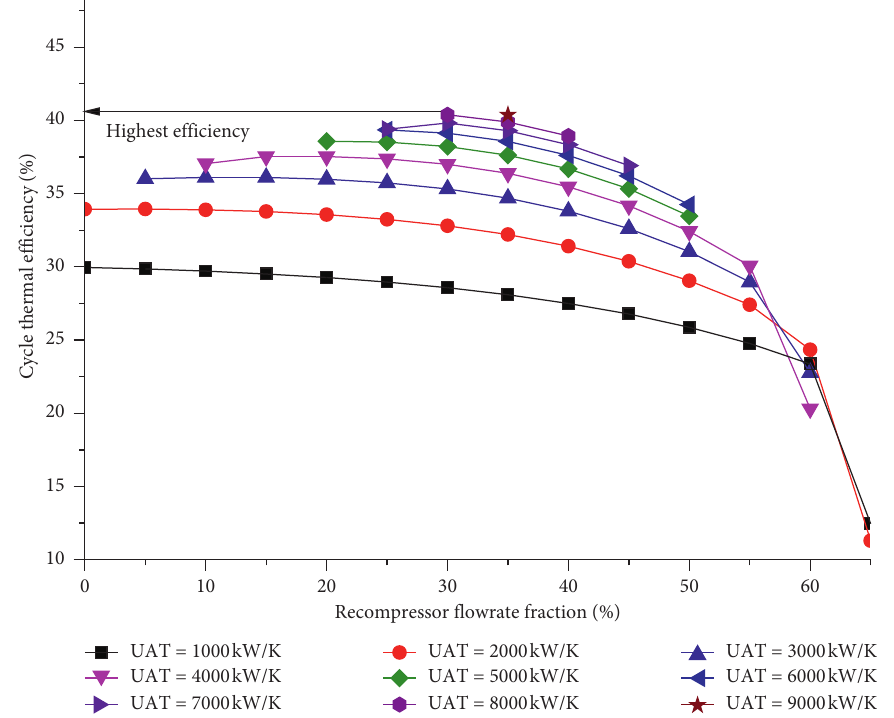
Figure 14: Effects of recuperator UA and recompressor flow rate fraction on the cycle thermal efficiency for water-cooled RBC.